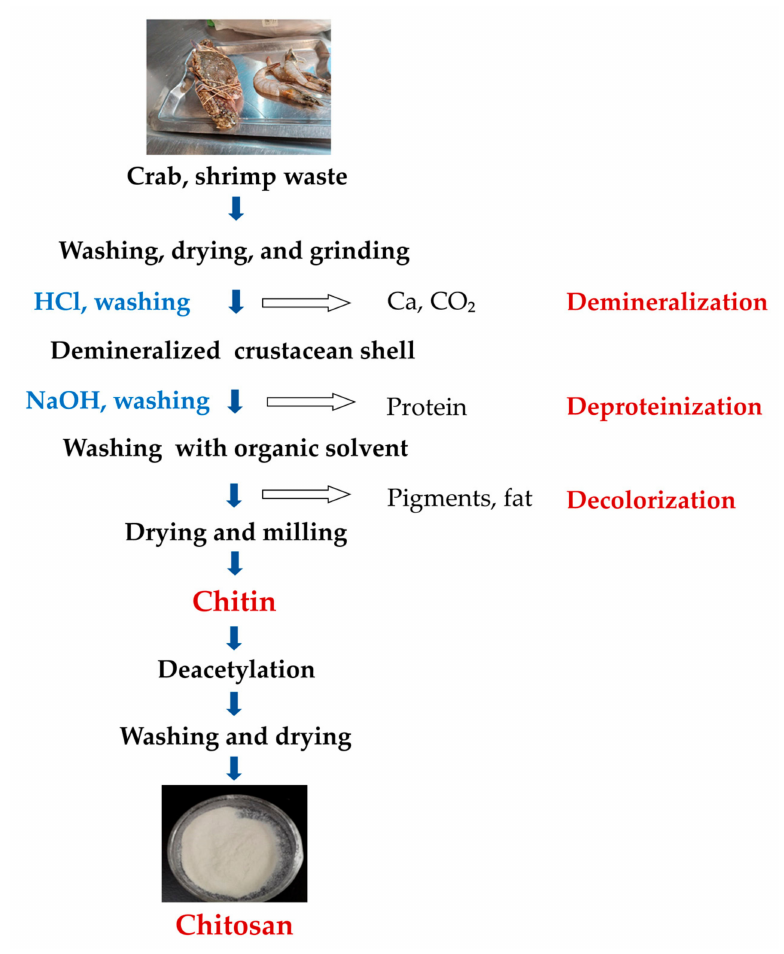
Figure 2. A simplified flow diagram of chitin and CS preparation